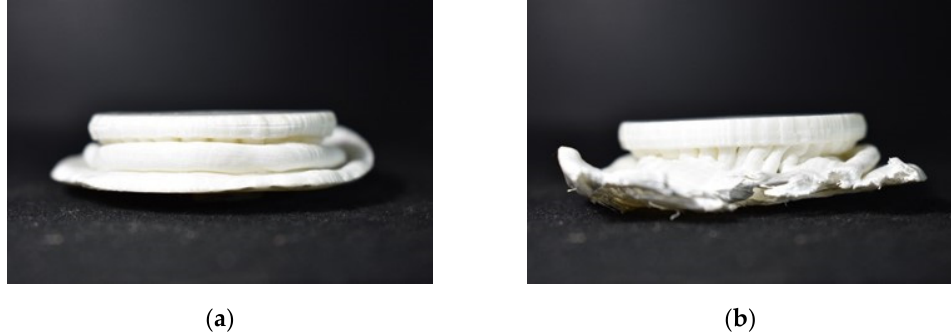
Figure 20. ( a ) Compressed model; ( b ) Failed model while testing.